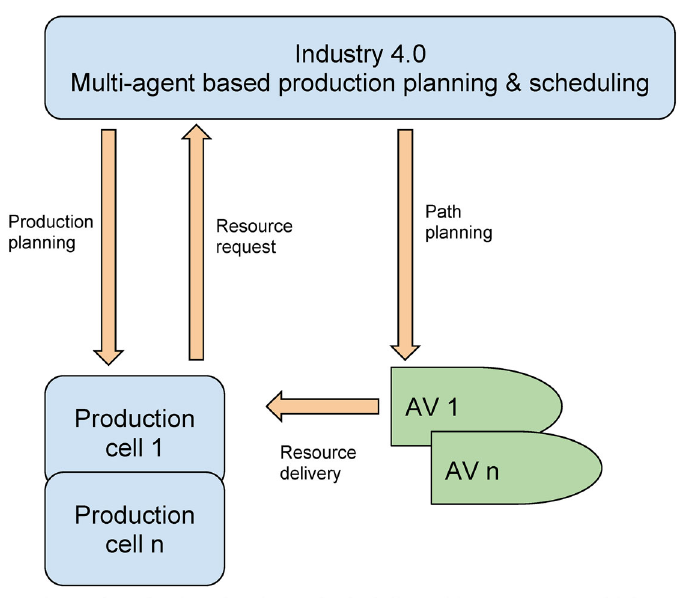
Fig. 3. Integration and production planning and scheduling with autonomous